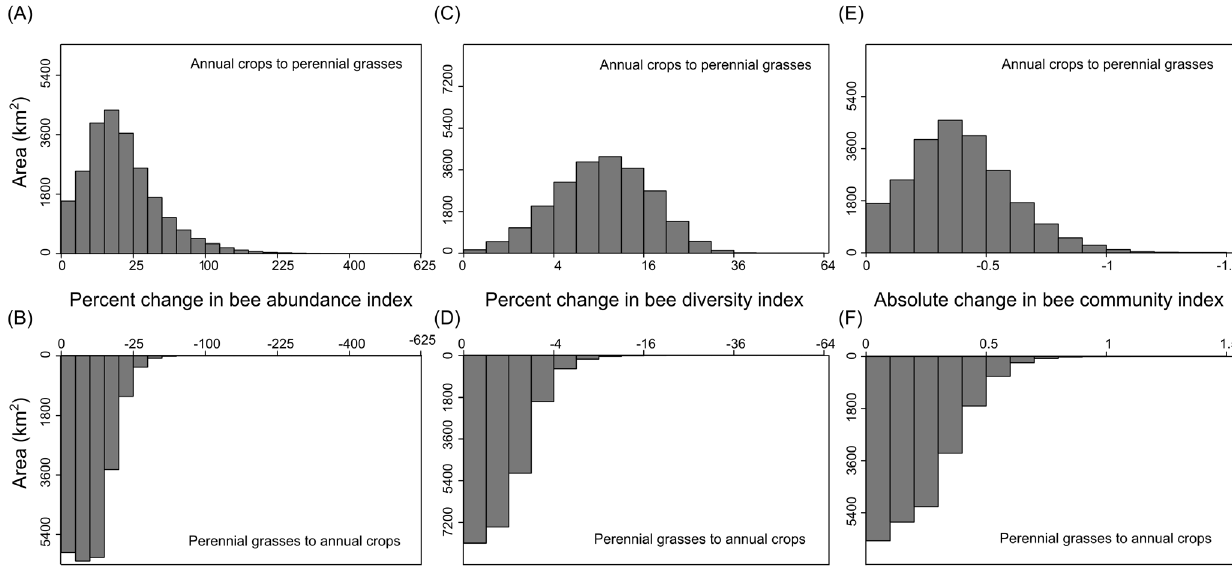
Figure 4. Distribution of percent change for measured bee metrics. The distribution of percent change values calculated under the perennial grassland bioenergy scenario for bee abundance (A), diversity (C), and community composition (E) and under the annual bioenergy scenario for bee abundance (B), diversity (D), and community composition (F). In the annual bioenergy scenario 600,000 ha of marginal grassland was converted into annual bioenergy crops, whereas in the perennial bioenergy scenario 600,000 ha of marginal agricultural land were converted into grassland. Predicted changes in bee communities are only shown for the lower portion of the state where empirical data were collected.